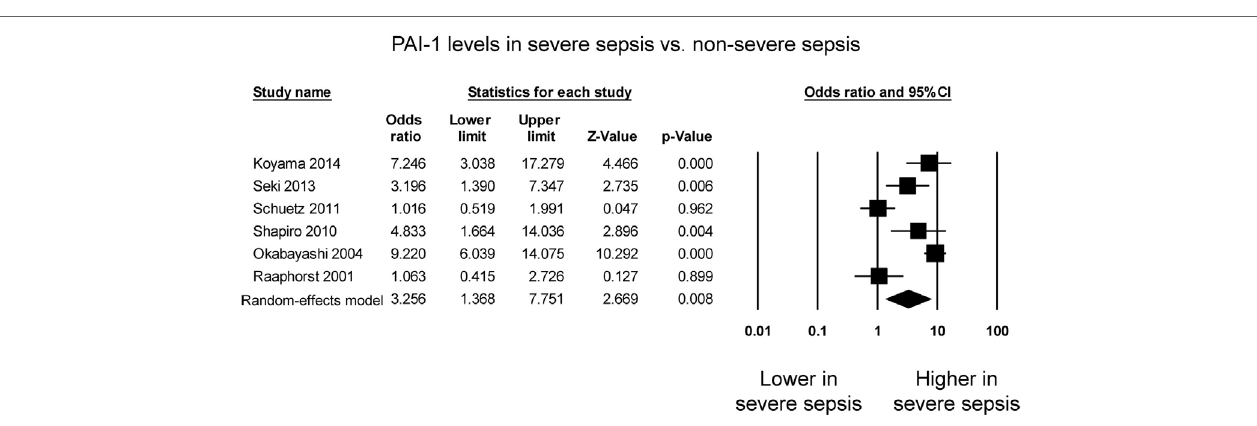
FigURe 3 | Forest plot comparing plasminogen activator inhibitor-1 (PAI-1) levels between patients with severe sepsis and those with non-severe sepsis.